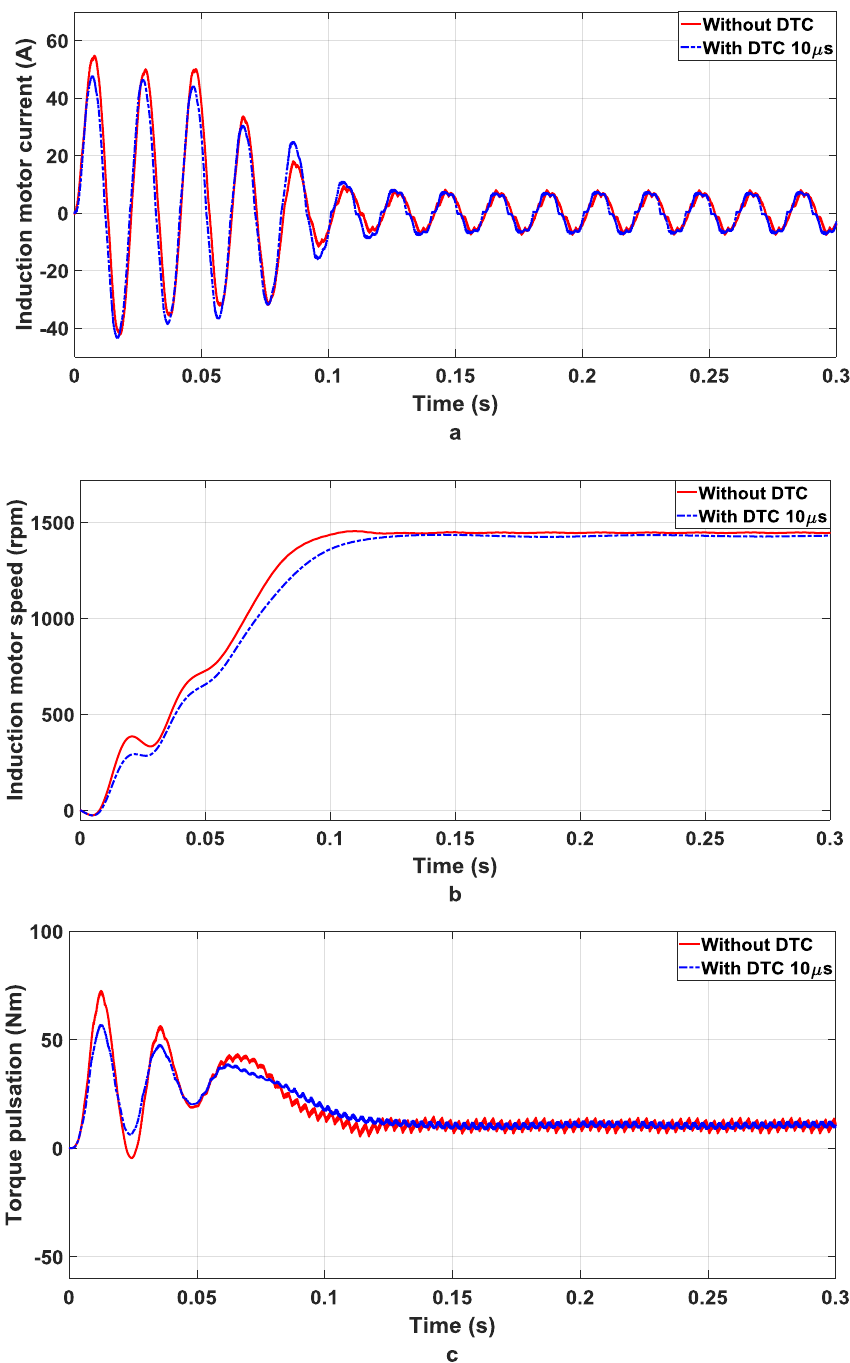
Figure 12. Without / with 10 µ s DTC ( a ) induction motor current ( b ) speed of induction motor Figure 12. Without/with 10 𝜇 s DTC ( a ) induction motor current ( b ) speed of induction motor ( c ) Torque pulsation. ( c ) Torque